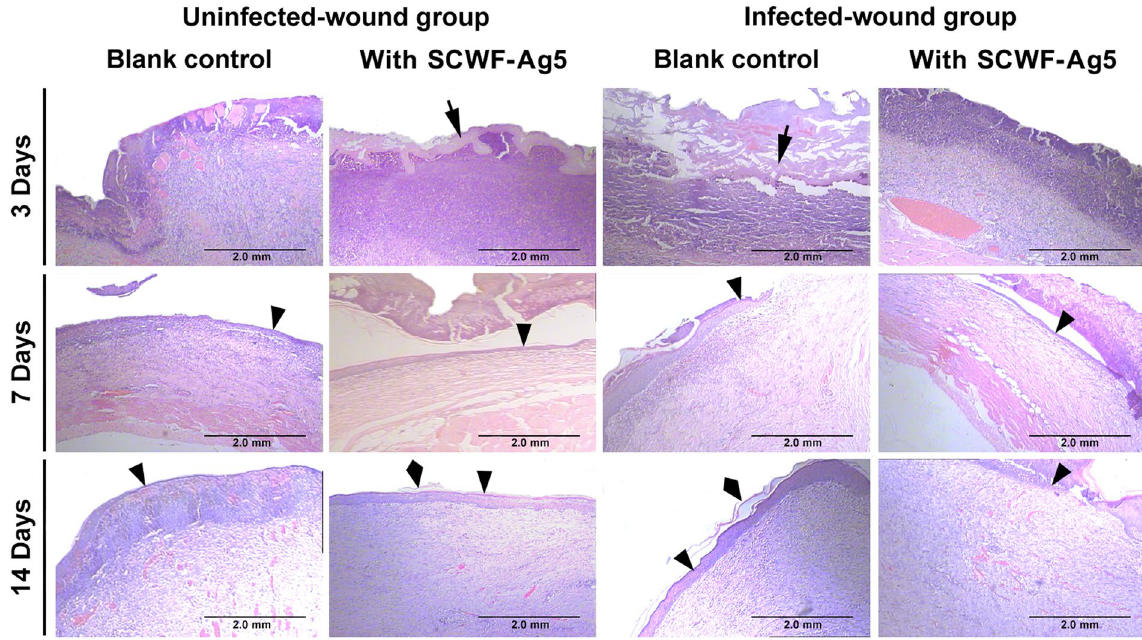
Figure 8. Histological evaluation of skin wound healing at days 3, 7, and 14. Photomicrographs showing sections of skin tissues with H&E staining. Black arrows, triangles, and quadrangles, respectively,